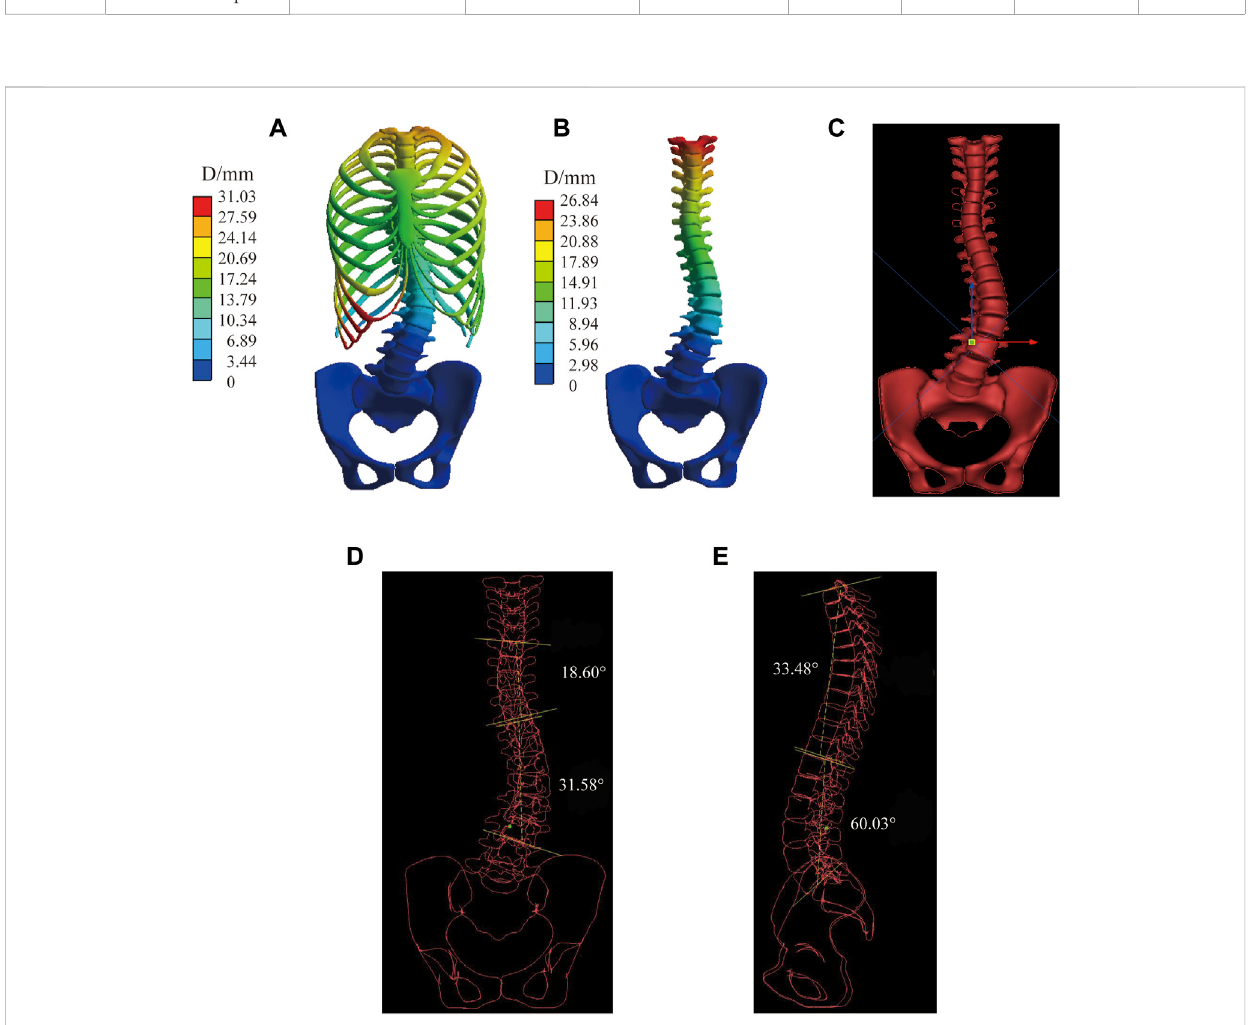
FIGURE 5 MeasurementprocessforvirtualX-rayinthemost fl exiblespineinC1. (A) Displacementofthespinemodel. (B) Displacementofvertebralbodies. (C) GeometrymodelcastinvirtualX-ray. (D) MeasurementoftheCobbangleinthecoronalplane. (E) MeasurementoftheKyphosisandLordosisangleinthe sagittal